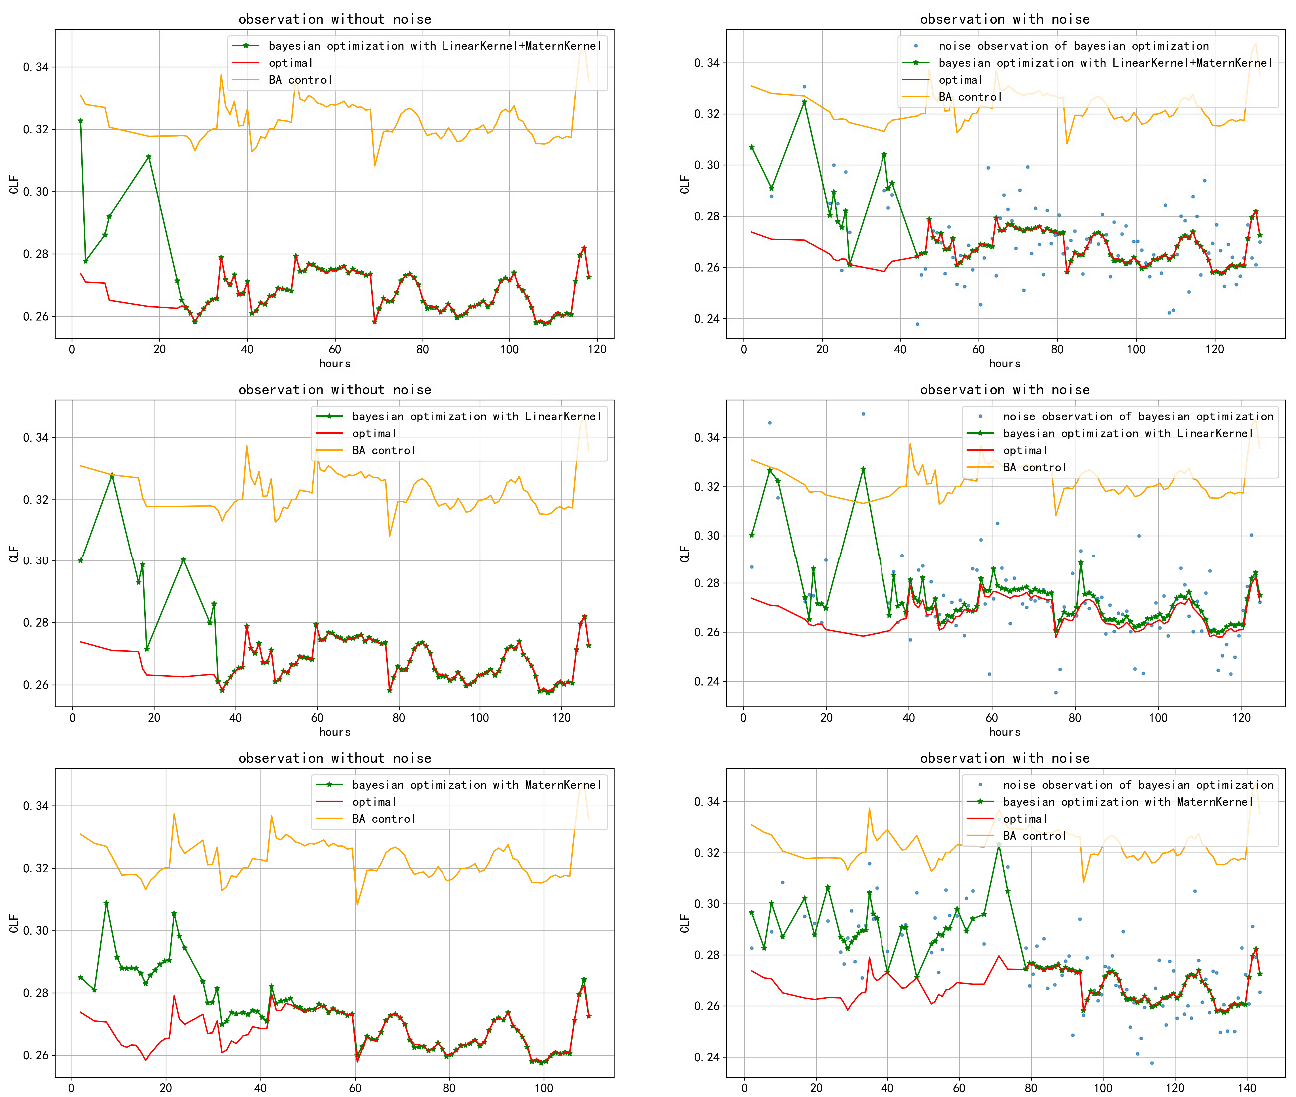
Figure 6. Bayesian optimization process for power-on chiller 1.